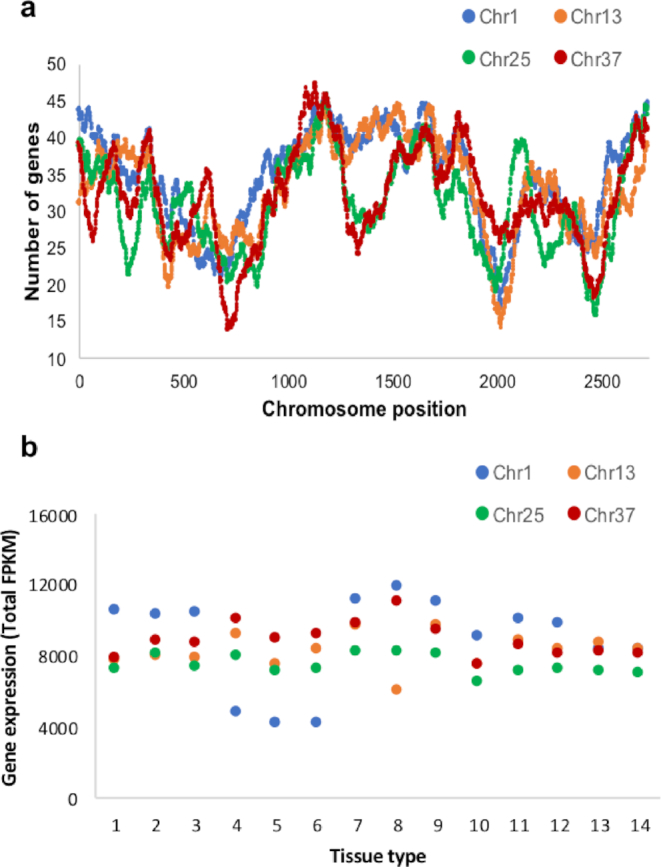
Assessment of the origin of polyploid blueberry. (a) Gene content comparison of homoeologous chromosomes (1, 13, 25, and 37) plotted along 2,725 collinear syntenic regions. This analysis for all 48 chromosomes can be regenerated here: [65]. (b) Gene expression comparison (FPKM; fragments per kilobase per million) among the same four homoeologous chromosomes across different blueberry tissues (1 = flower bud; 2 = flower at anthesis; 3 = petal fall; 4 = green fruit; 5 = pink fruit; 6 = ripe fruit; 7, 8 = leaf collected at 12 p.m. and 12 a.m., respectively; 9, 10, 11 = methyl jasmonate-treated leaf collected after 1 hour, 8 hours, and 24 hours, respectively; 12 = shoot; 13 = root; 14 = salt-treated root).